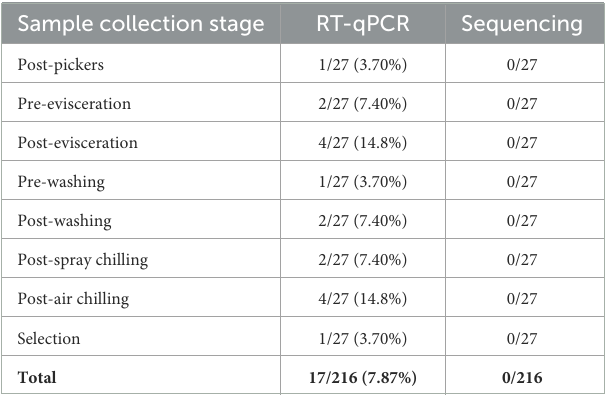
TABLE 3 Influenza A virus detection results by step of poultry processing plants.